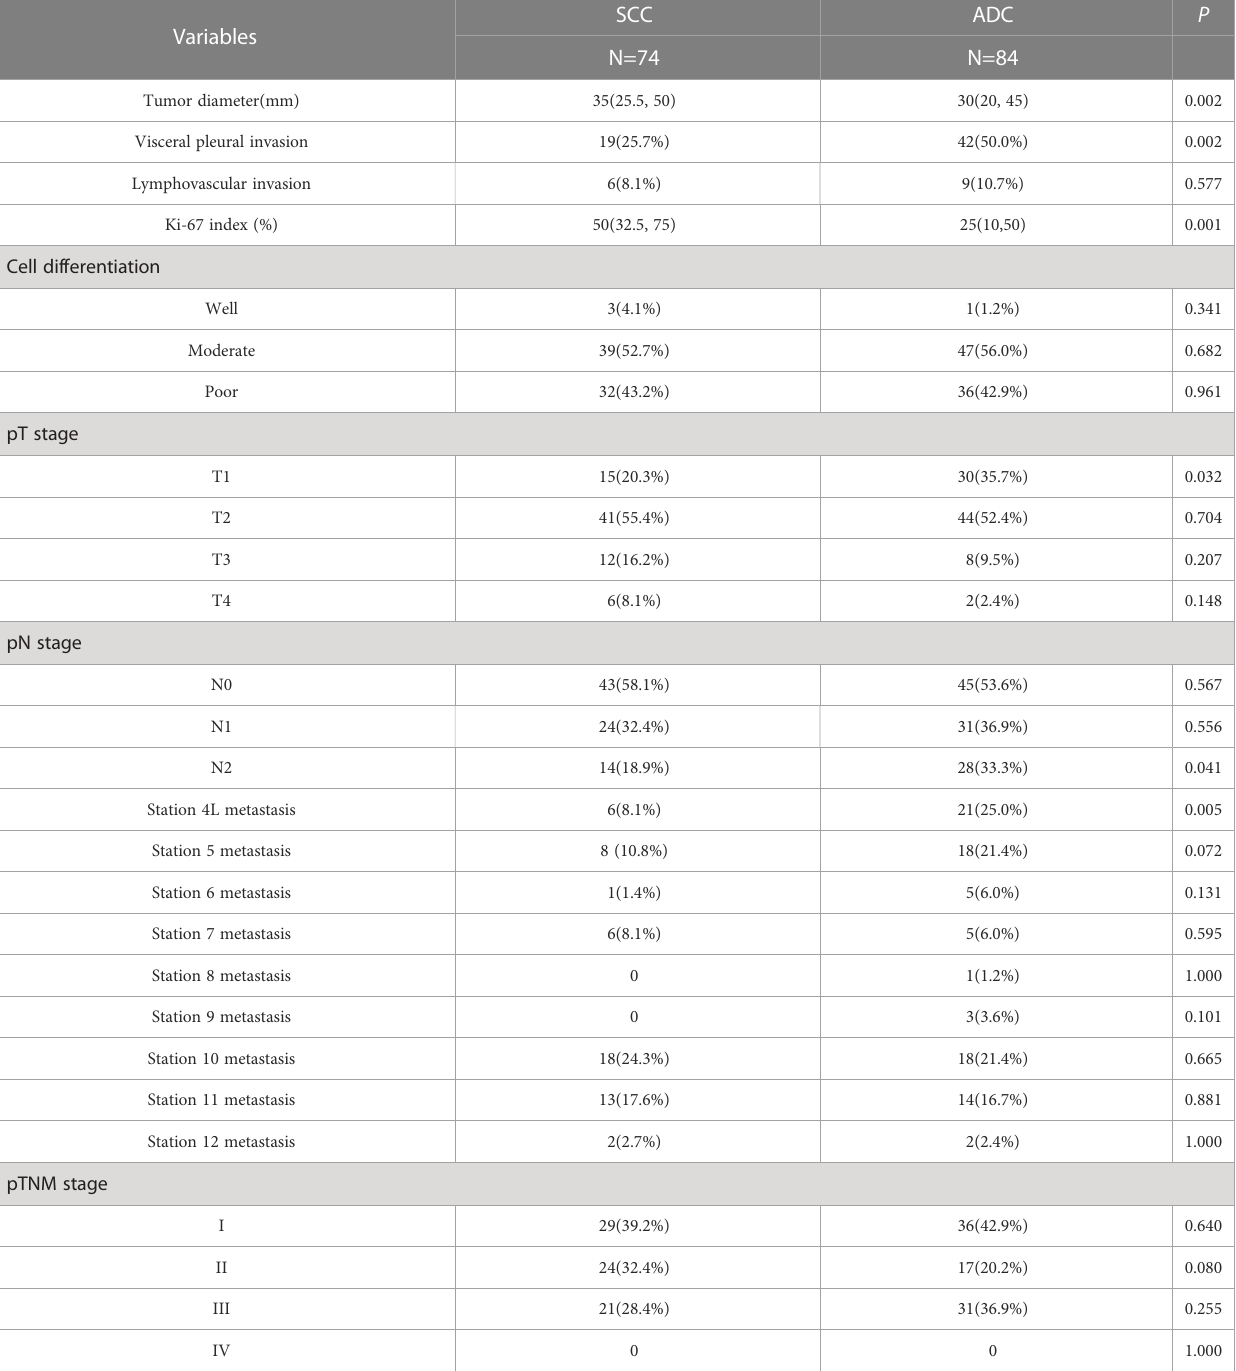
SCC, squamous cell carcinoma; ADC,